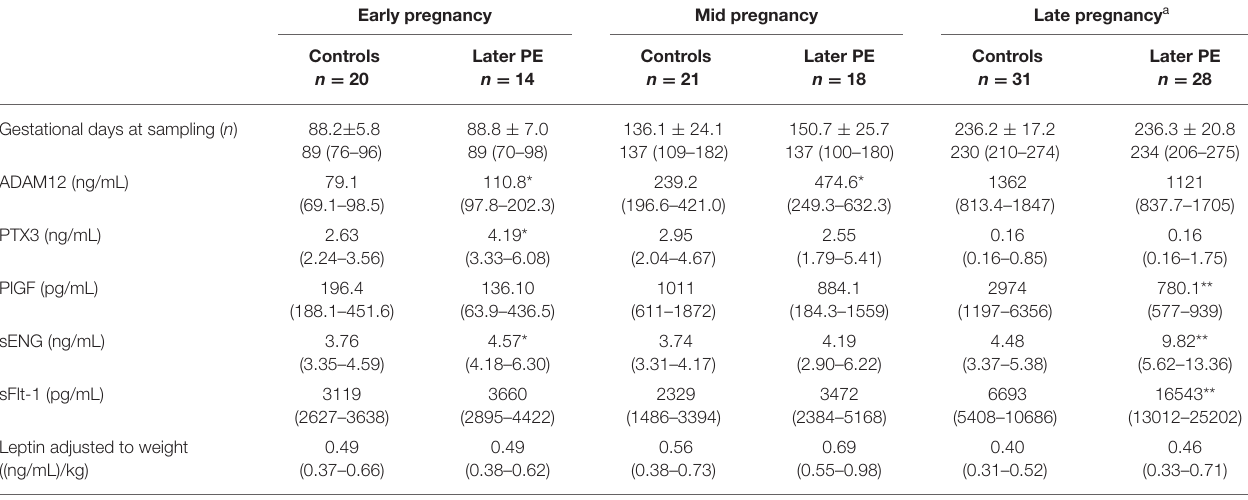
TABLE 2 | Measured concentrations of biomarkers in maternal sera sampled in early, mid, and late pregnancy.